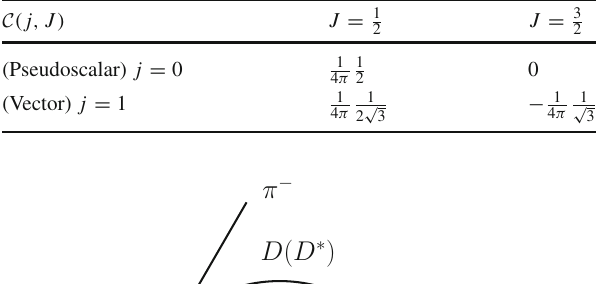
Table 1 C ( j , J ) coefficients in Eq. (16)